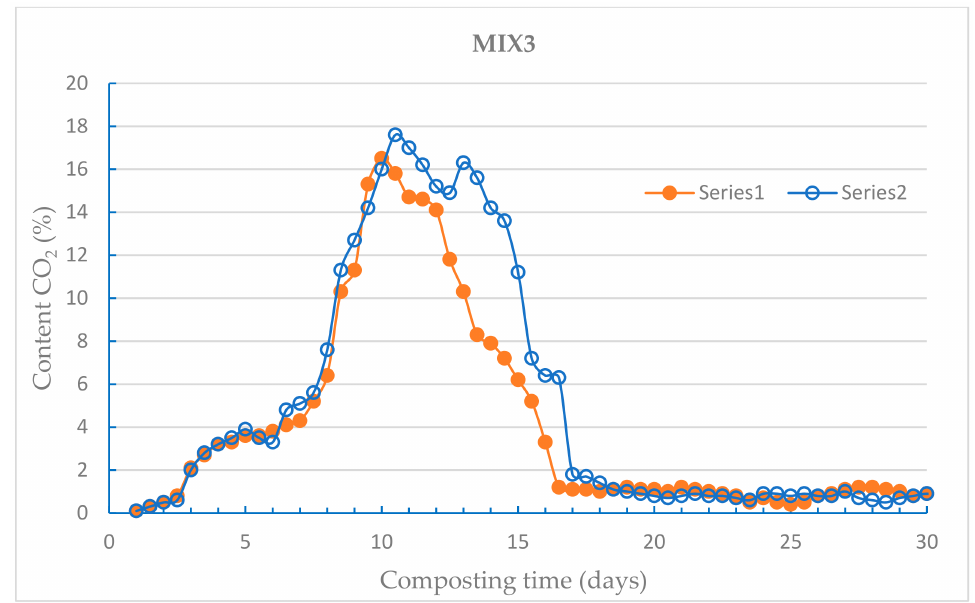
Figure 7. Changes in content CO 2 during the composting of